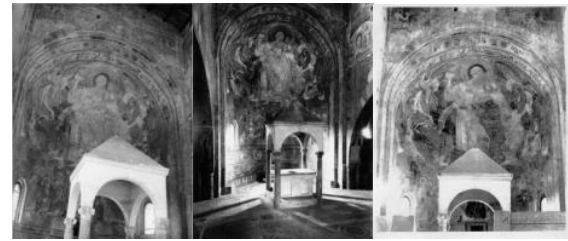
Figure 2. The fresco as it was in 1925 (left –courtesy of ICCD), 1954 (centre – courtesy of ICCD) and 1969 (right – made by Hutzel Max. Courtesy of Research Library, The Getty Research Institute, Los Angeles -